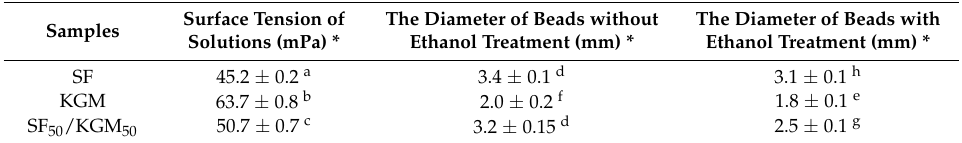
Table 1. The surface tension of SF, KGM, and SF 50 /KGM 50 solutions and diameters of SF, KGM, and SF 50 /KGM 50 beads.